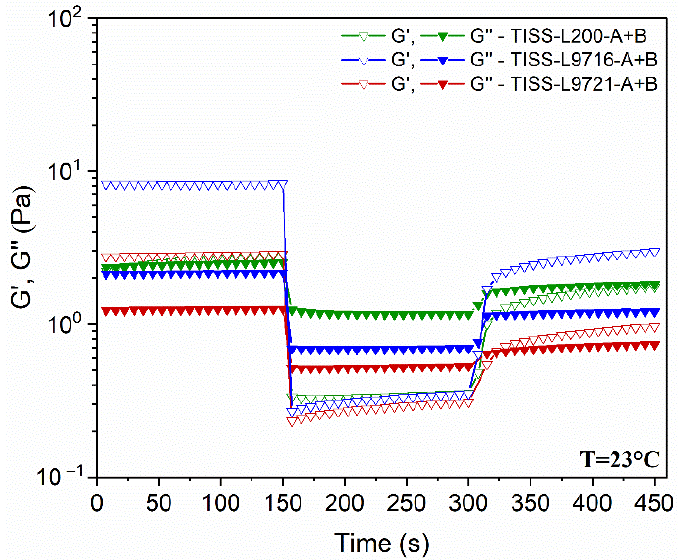
Figure 7. Three-step time test for TISS liquid paints, prepared with various binders (L200, L9716 in L9721) and black pigment: 1st step: constant low deformation in linear viscoelastic range ( γ = 1%, ω = 1 Hz); 2nd step: constant high deformation in the range of destructive conditions ( γ = 100%, ω = 1 Hz); 3rd step: constant low deformation ( γ = 1%, ω = 1 Hz), the same as in 1st step. All liquid paints were measured after the addition of catalyst Desmodur N75.